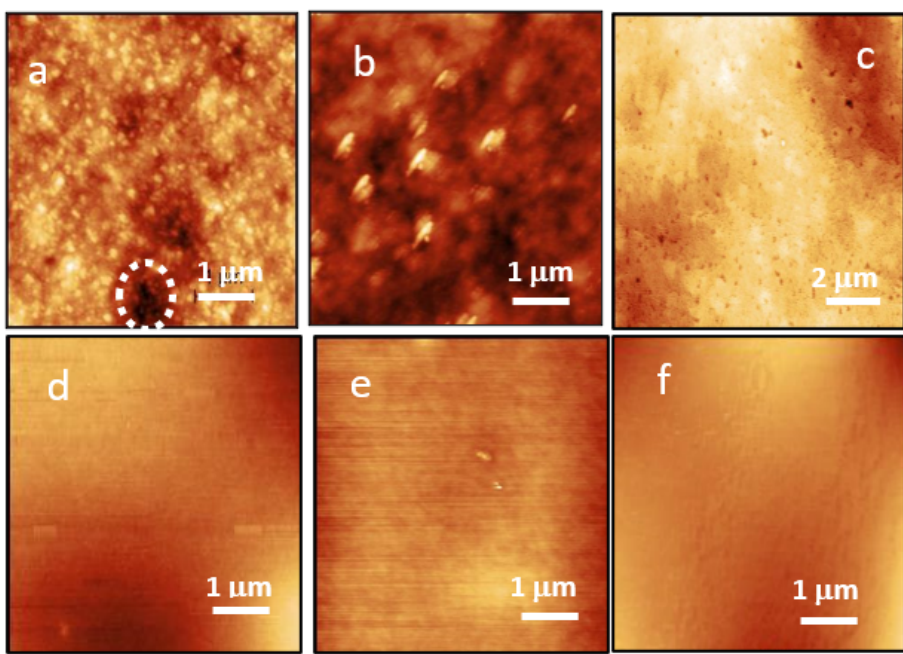
Figure 3. Tapping mode AFM images: ( a ) Corapack’s cellulose substrate, with the white circle surrounding the small fabrication defect. Deposited by spray coating on cellulose: ( b ) PVA-Q; ( c ) PVB-PCA; ( d ) Corapack’s PLA substrate. Deposited on PLA: ( e ) PVB-PCA deposited by spray coating; ( f ) PVB-PCA deposited by spin coating.